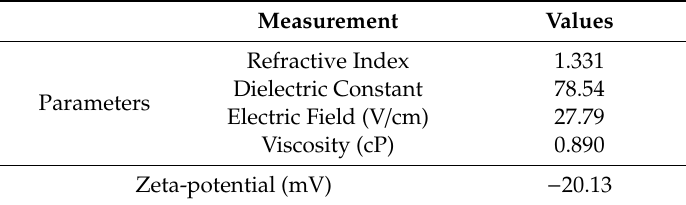
Table 2. Parameters for ζ -potential measurement and value of zeta-potential of